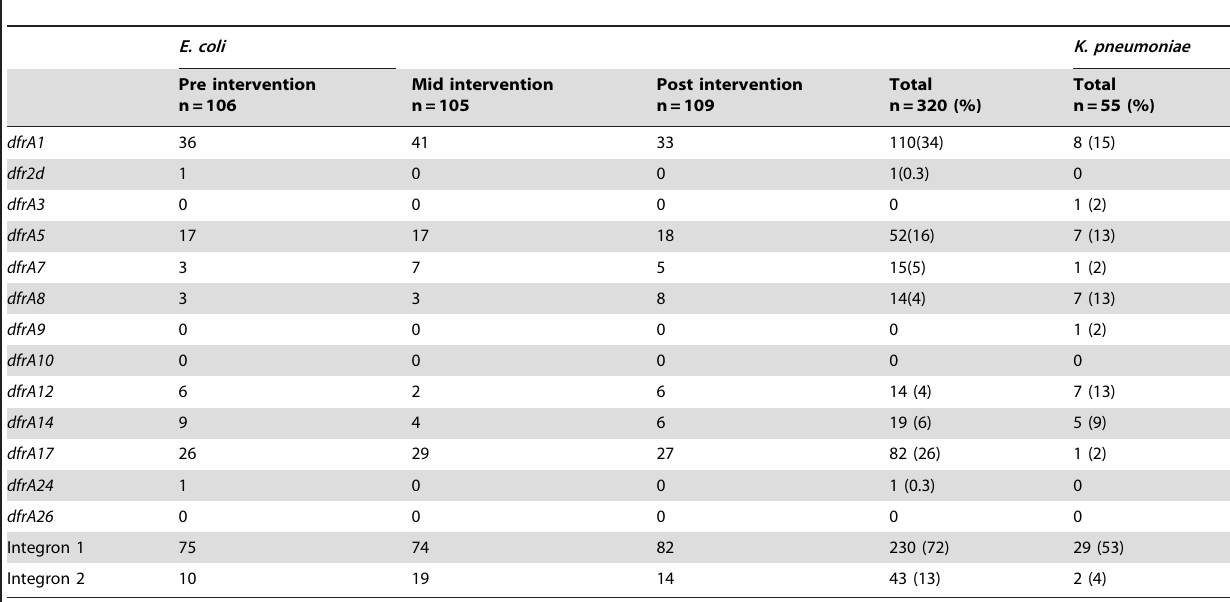
Table 3. No. of isolates positive for the investigated dfr- genes and integrons in E. coli (n =320) and K. pneumoniae (n =54) collected at time periods before and during the trimethoprim